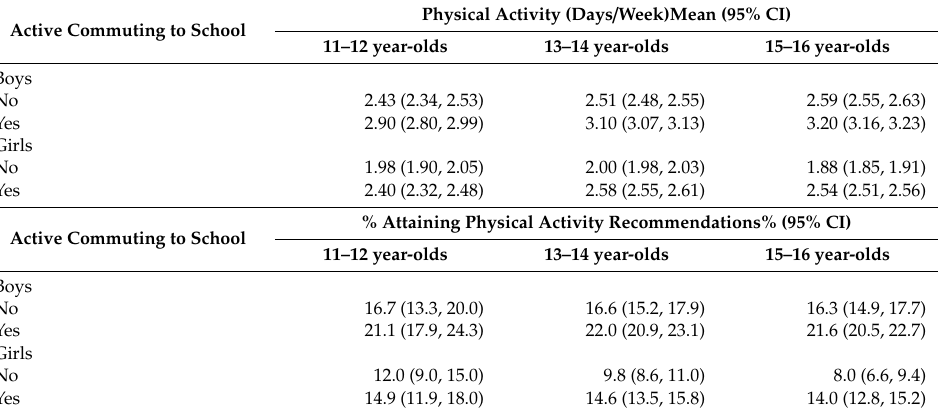
Table 2. Mean frequency of physical activity (day / week) and the prevalence of attaining the physical recommendations according to active commuting by age